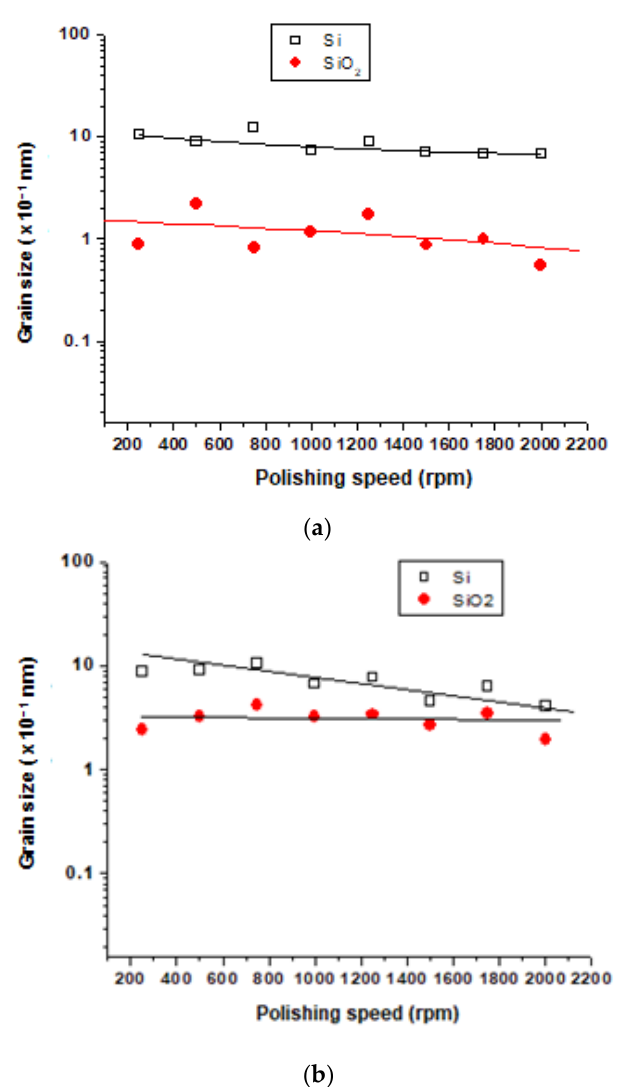
Figure 5. Grain size of Si and SiO 2 particles at different polishing speeds for ( a ) white granite, and ( b ) Black granite (Canadian anorthosite), using 508 mm/min feed rate, 0.2 bar pressure, and 60 grit abrasive.